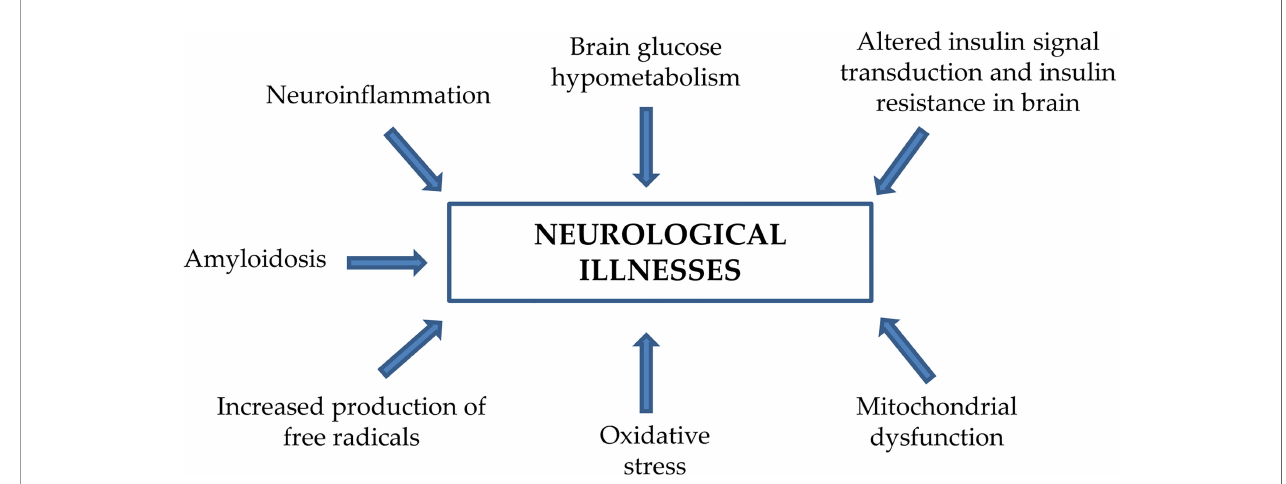
FIGURE 1 | Expression of common pathogenic manifestations in the brain of patients with several neurological